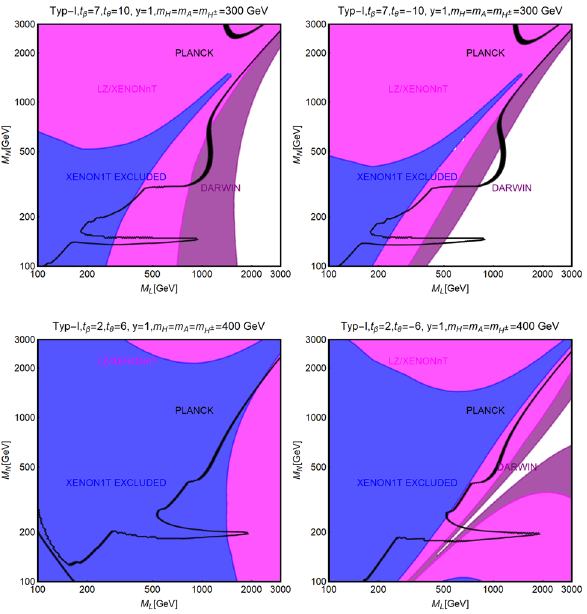
Fig. 4 Comparison between relic density constraints and limit/projected sensitivities, in the bidimensional plane ( M L , M N ) in the Type-I model (abbreviated Typ-I) for some assignations of θ, tan β and m H , A , H ± , reported on top of the panel. In each panel the black curve represents the isocontour of the correct relic density while the blue region is excluded by current constraints from XENON1T. The magenta and purple regions will be ruled out in case of null signals from, respectively, XENONnT/LZ and DARWIN